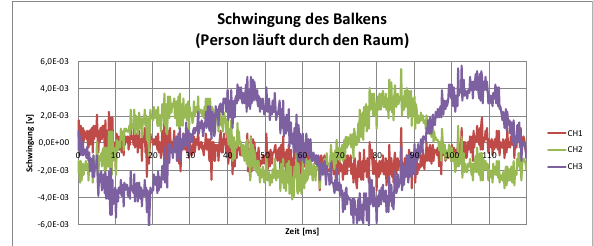
Figure 9. Measured vibration speed in x- (red), y- (green) and z-direction (violet) while a person walks through the room